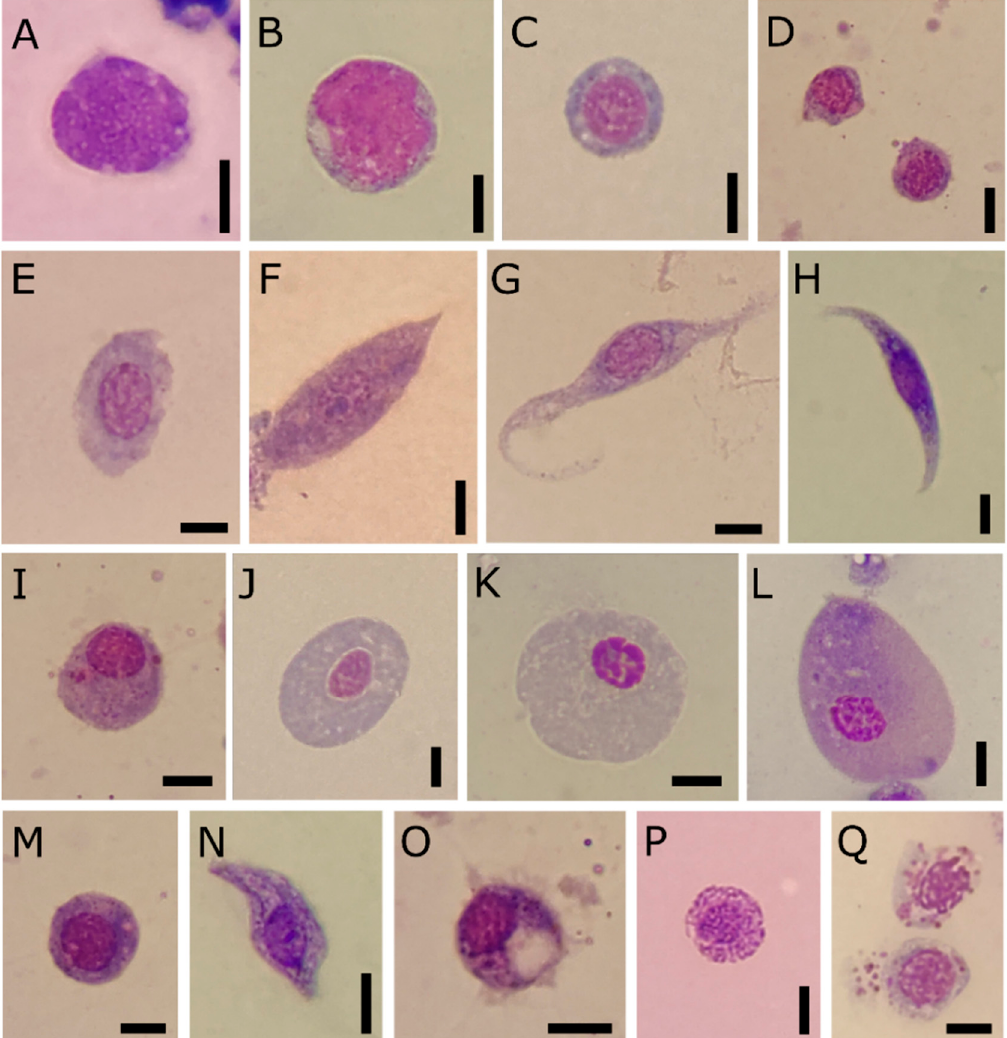
Figure 1. Light micrographs of haemolymph smears from T. molitor , May-Grünwald Giemsa stained. The metachromasia reveals specific morphological properties of different types. ( A – D ) Prohaemocytes. ( E ) Early plasmatocytes with large cytoplasm and heterochromatic nucleus. ( F – H ) Plasmatocytes as elongate cells with mature chromatin and eosinophilic cytoplasm ( F ), or spindle-shaped ( G , H ) with small basophilic granules in the cytoplasm. ( I ) Immature oenocytoid with eccentric nucleus and eosinophilic granules. ( J – L ) Differentiated oenocytoids with low nuclear-to-cytoplasmic ratio and homogenous cytoplasm. ( M ) Intermediate figure with basophilic cytoplasm and eosinophilic granules. ( N – O ) Circulating granular cells appear elongated in shape with large basophilic granules or round in shape and with eosinophilic granules ( P ), easily lysed and degranulated ( Q ). Bars: 5 μ m.